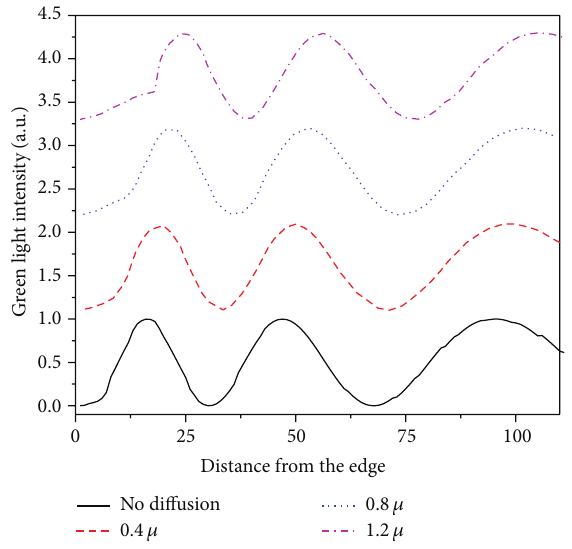
Figure 5: Results of light intensity calculations for interference pattern. The formation of the outer layer due to gas diffusion results in widening of the peaks.